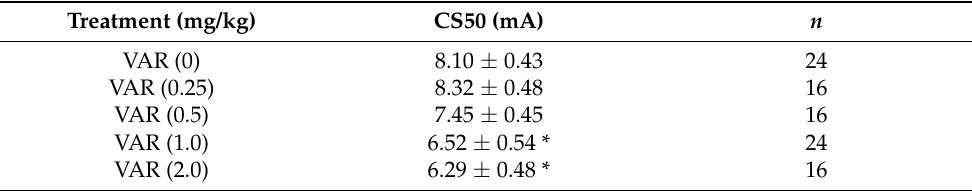
Table 1. Effect of varenicline (VAR) on the threshold for tonic-clonic seizures in mice. Treatment